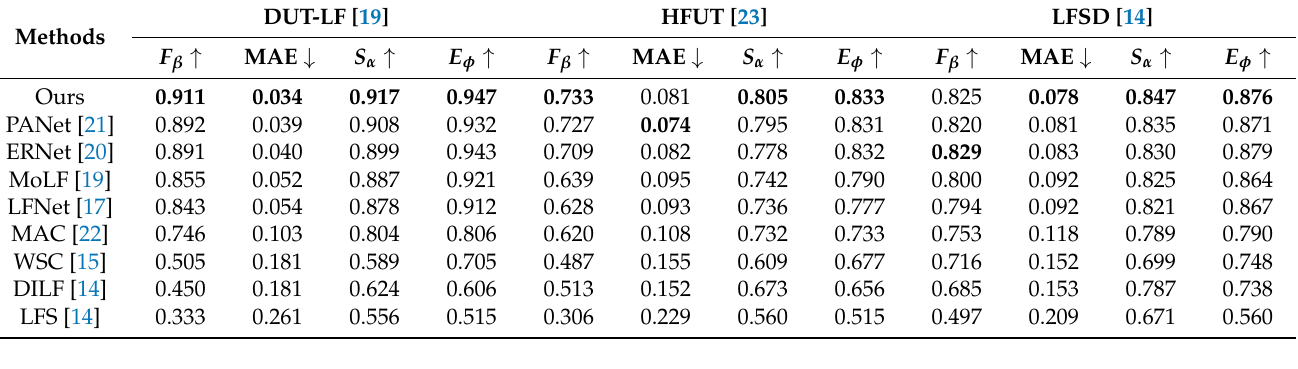
Table 1. Quantitative comparisons on three light-field datasets. The best results are marked in bold. ↑ and ↓ denote larger and smaller is better respectively.